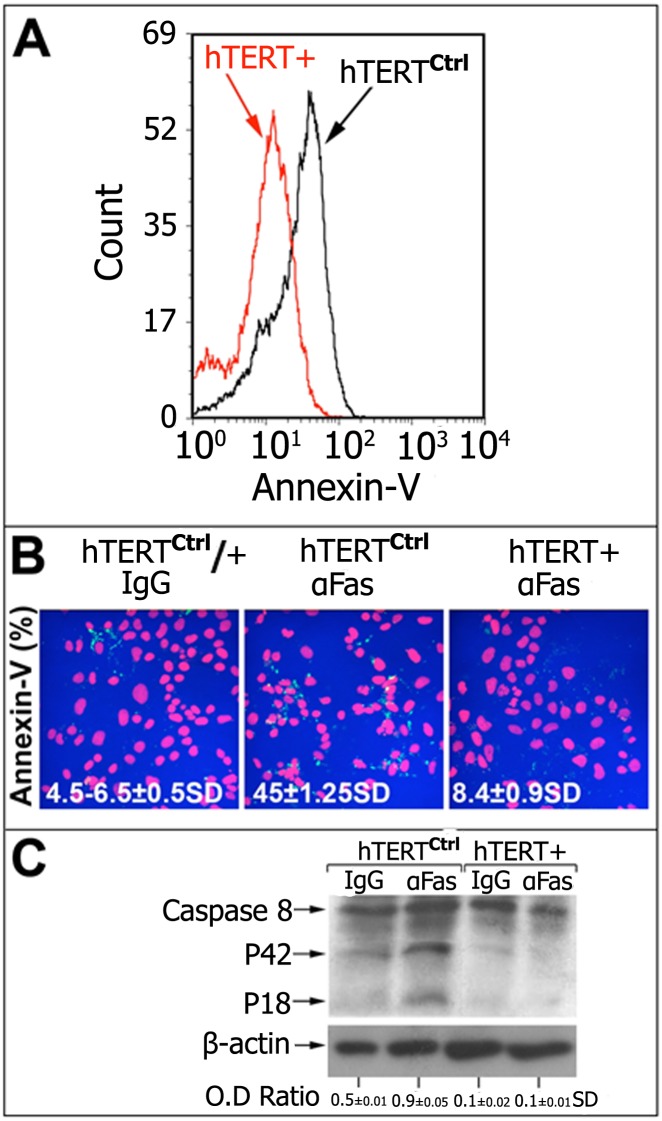
Decreased Fas-induced apoptosis in hTERT+ vs. hTERTctrl transfected MLE cells.MLE cells were transfected with hTERT or control expression vector, and exposed to Fas or control IgG mAb (10 μg/ml, 24h). (A) Histogram plot and (B) confocal microscopy of Annexin V staining (blue) and PI (red) in hTERT+ vs. hTERTctrl cells showing decreased Annexin V staining in hTERT+ when compared to hTERTctrl transfected cells (MLE). Inserted numbers represent the percentage of Annexin V-stained cells (blue) among total cells in the field (red) with standard deviation (SD). 10–15 fields were counted. (C) Western blots of caspase-8 cleavage into p42 and p18 subunits. Cleaved/uncleaved-caspase-8 optical density (OD) ratios are presented, showing decreased caspase 8 cleavage in hTERT+ when compared to the hTERTctrl-transfected MLE cell line. Representative results of two different experiments with similar results.